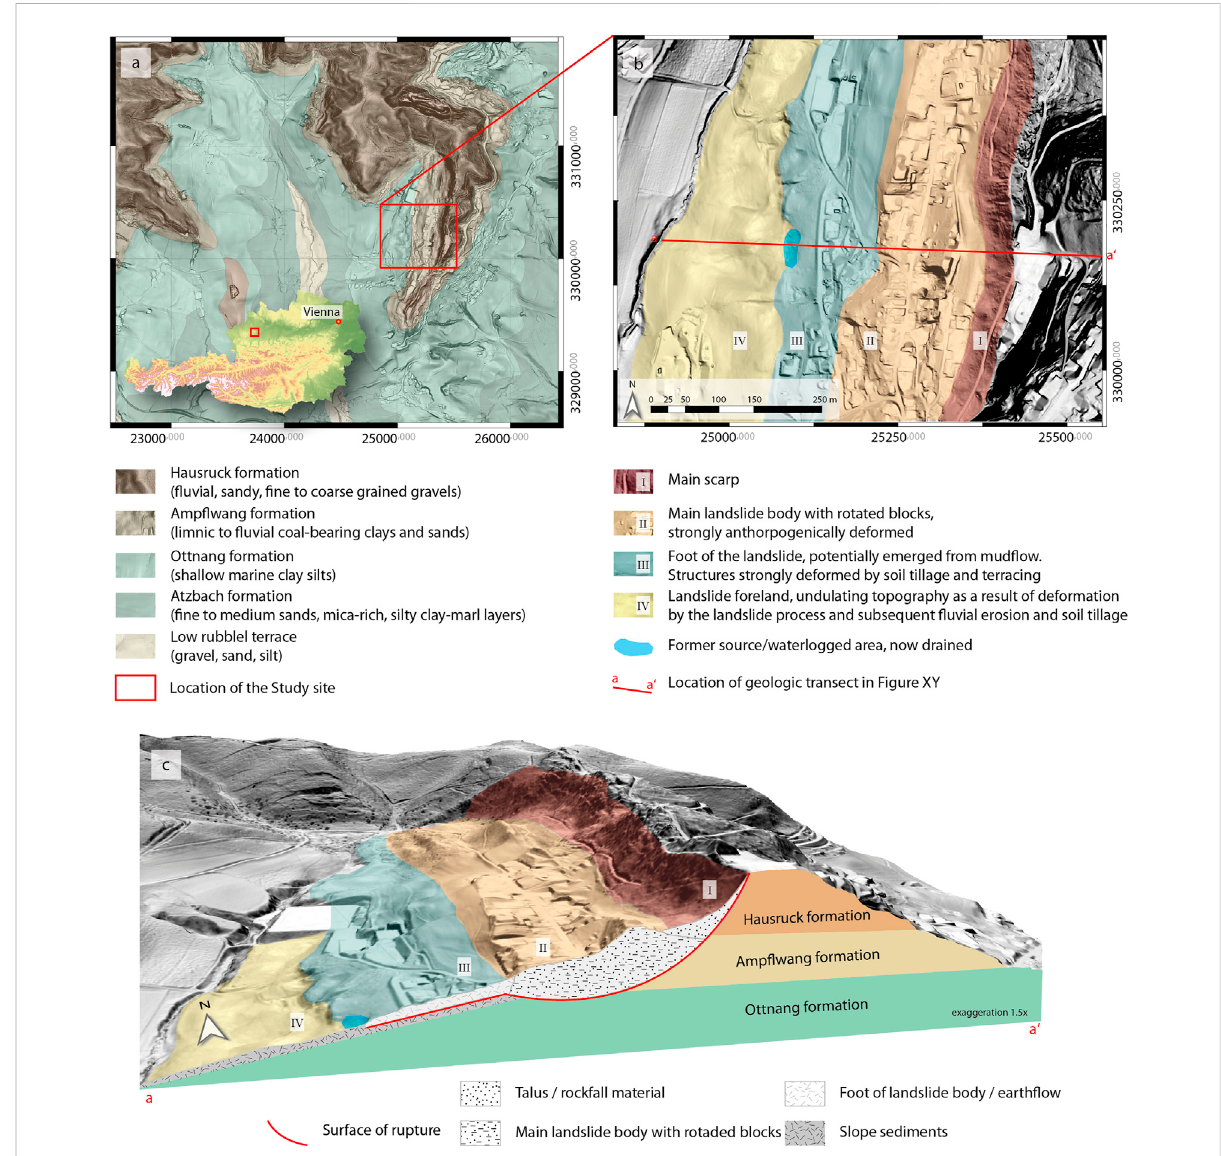
FIGURE 1 Details onthestudy siteWolfsegg with (A) geological overviewofthesouth-easternpartsoftheHausruckmountain range inAustria (Krenmayr andSchnabel,2006), (B) shadeddigital terrainmodel withinterpretedmorphological zones(I-IV) and (C) 3D-sceneofthestudysitewith interpreted morphological zones, geology as well as asubsurface model of the slope and landslide body. The reconstruction of the subsurface characteristics is based on the geomorphology of the study site and adopts to the classi fi cation of rotational slides by Cruden and Varnes (1996). Elevation data for Figures a – c are based on airborne laserscanning data, resolution 0.5 m, April 2015 (Datasource: Land Oberösterreich — data.